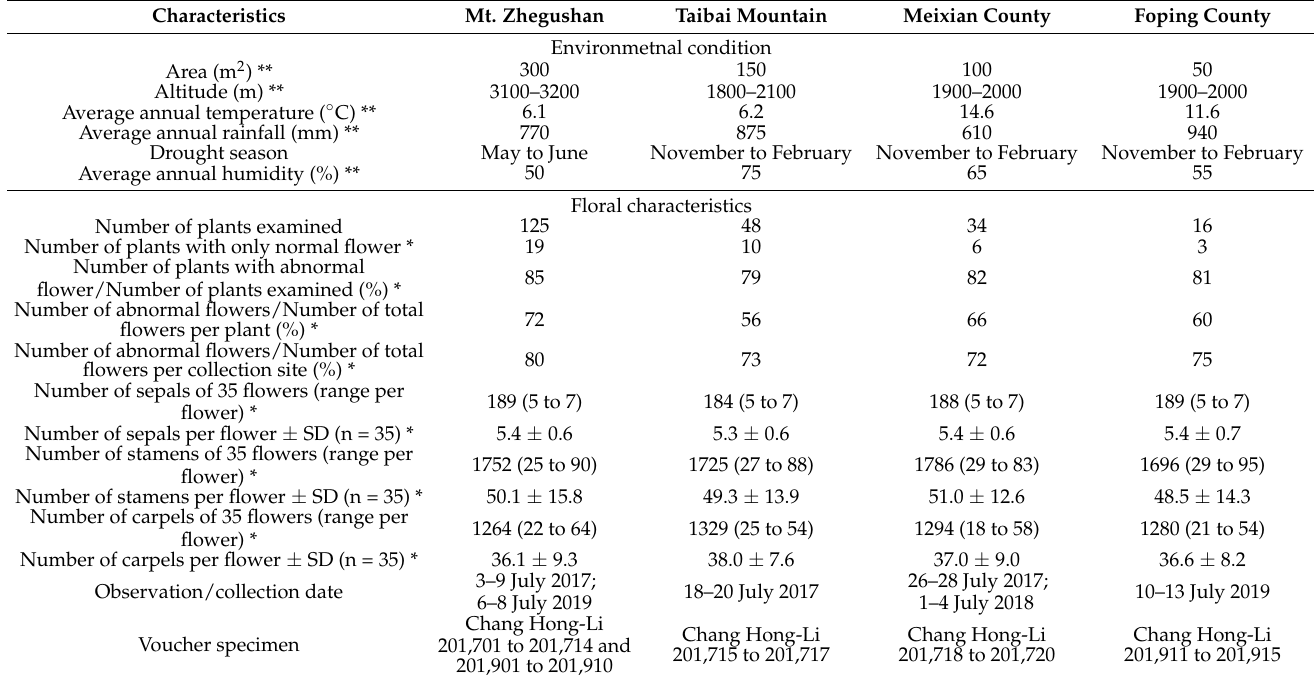
Table 1. Characteristics of the four collection sites (i.e., Mt. Zhegushan, Taibai Mountain, Meixian County, and Foping County) and floral organs of Anemone barbulata